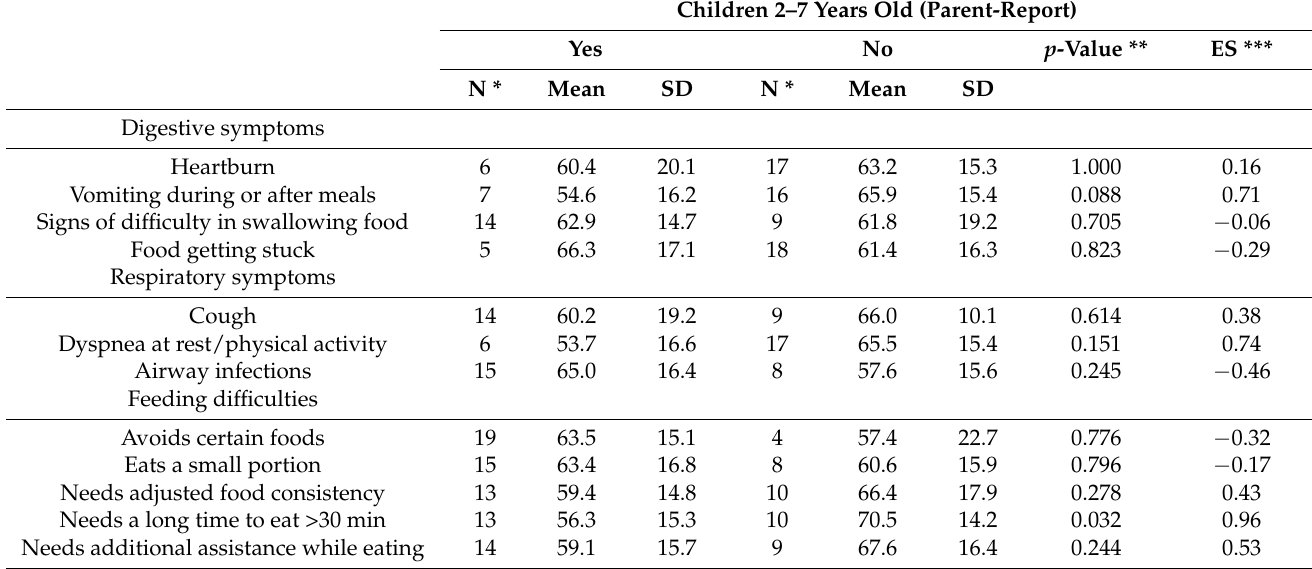
Table 5. Comparison of the total scores on the EA-QOL questionnaire between clinical subgroups in children aged 2–7. p < 0.05 values are